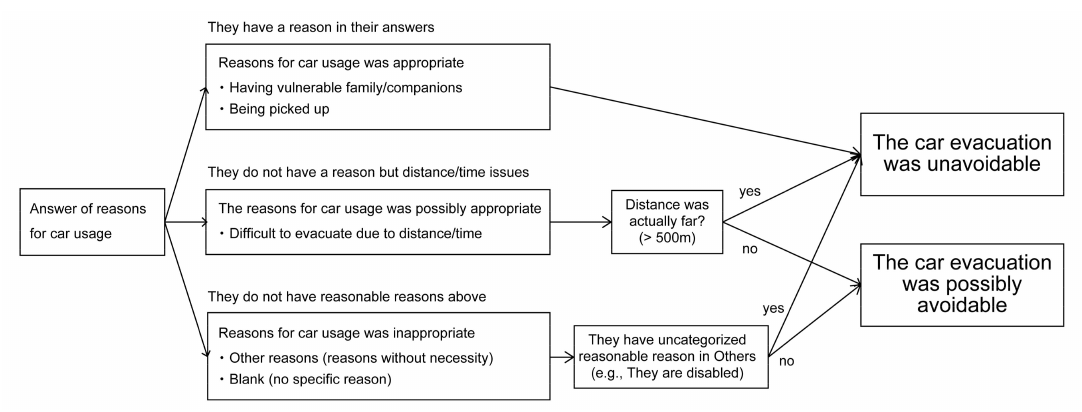
Figure 4. Schematic diagram of the evaluation process of car evacuation